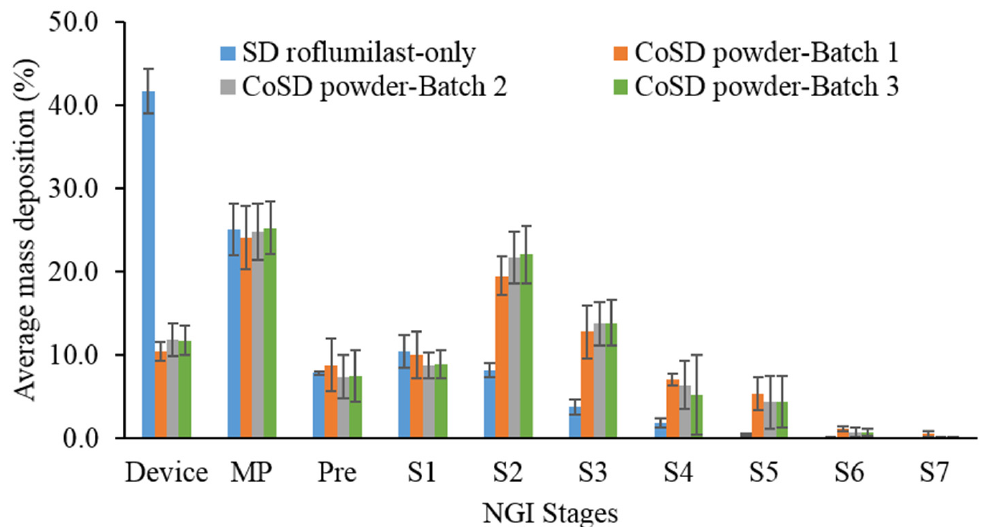
Figure 5. Drug deposition behavior of spray-dried (SD) and cospray-dried (CoSD) roflumilast powders on different stages of NGI (MP: Mouthpiece, Pre: Pre-separator, S1–S7 represents stages 1 to 7; error bars represent standard deviations, n = 3).